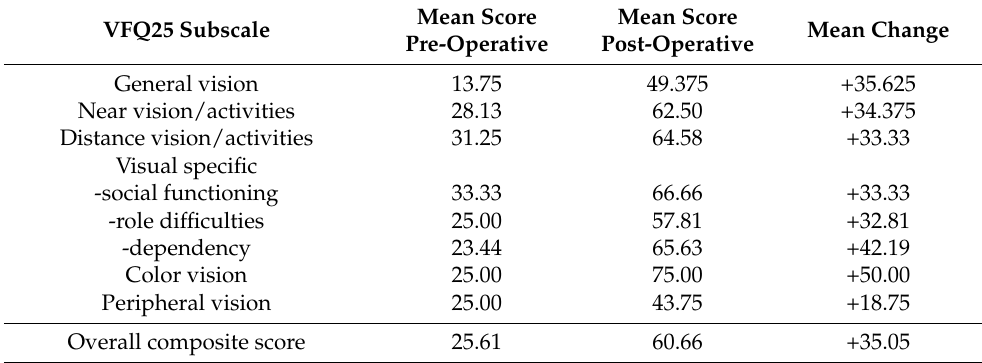
Table 4. VFQ25 subscale scores and overall composite score before and after